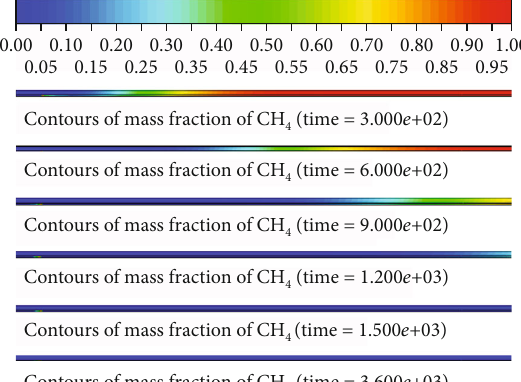
Figure 5: Grids for tunnel LNG pipeline simulation.